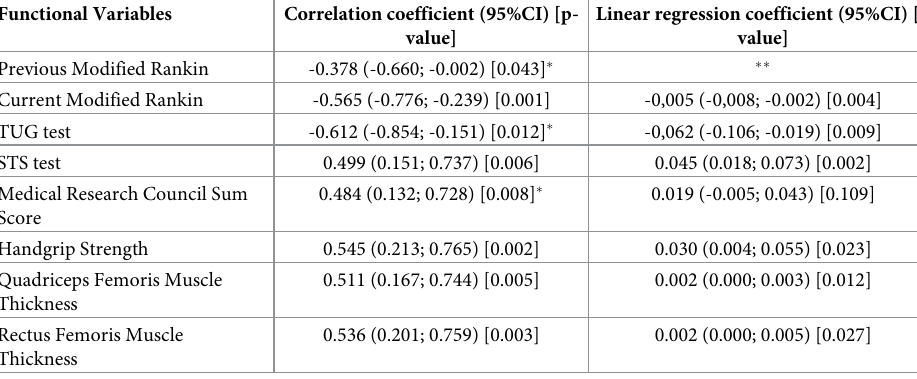
Table 4. Correlation and linear regression coefficient between Handheld Dynamometer and different functional